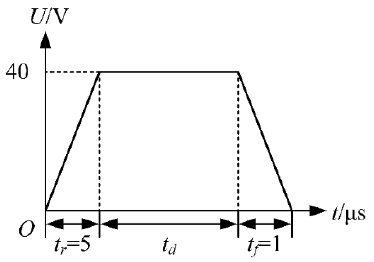
Figure 10. Trapezoidal waveform.